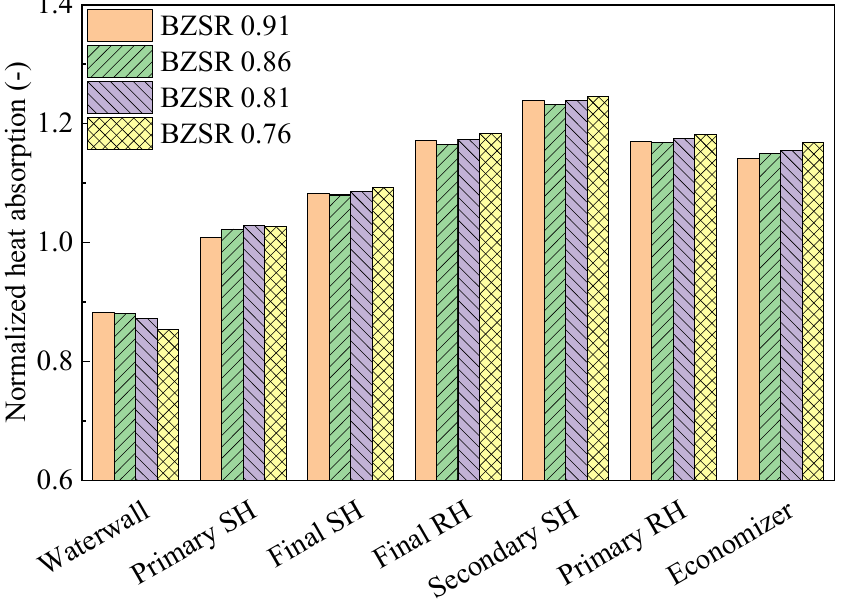
Figure 10. Normalized heat absorption with different burner zone stoichiometric ratios (BZSRs). Figure 11 shows the modelled NOx emissions at the boiler outlet and the FEGT, for